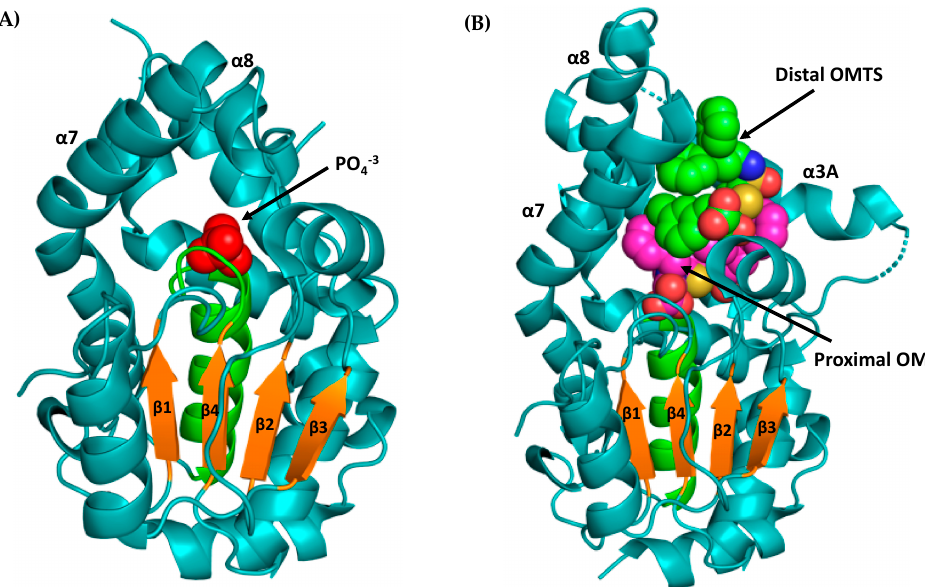
Figure 4. X ‐ ray crystal structures of mPTPB. ( A ) X ‐ ray structure of phosphate bound mPTPB in the flexible lid closed form Figure 4. X-ray crystal structures of mPTPB. ( A ) X-ray structure of phosphate bound mPTPB in the (PDB code: 1YWF). Product phosphate shown in red. The flexible lid ( α 7 ‐α 8) is in closed form. ( B ) X ‐ ray structure of OMTS flexible lid closed form (PDB code: 1YWF). Product phosphate shown in red. The flexible lid ( α 7- α 8) ((oxalylamino ‐ methylene) ‐ thiophene sulphonamide) bound mPTPB in open form (PDB code: 2OZ5). Proximal OMTS is in closed form. ( B ) X-ray structure of OMTS ((oxalylamino-methylene)-thiophene sulphonamide) shown in magenta and distal OMTS shown in green. The flexible lid ( α 7 ‐α 8) is in the open form to accommodate OMTS bound mPTPB in open form (PDB code: 2OZ5). Proximal OMTS shown in magenta and distal OMTS molecules. The p ‐ loop and β‐ sheets ( β 1, β 2, β 3 and β 4) are shown in green and orange, respectively. shown in green. The flexible lid ( α 7- α 8) is in the open form to accommodate OMTS molecules. The Table 1. Comparison table for mPTPA and mPTPB. p-loop and β -sheets ( β 1, β 2, β 3 and β 4) are shown in green and orange,